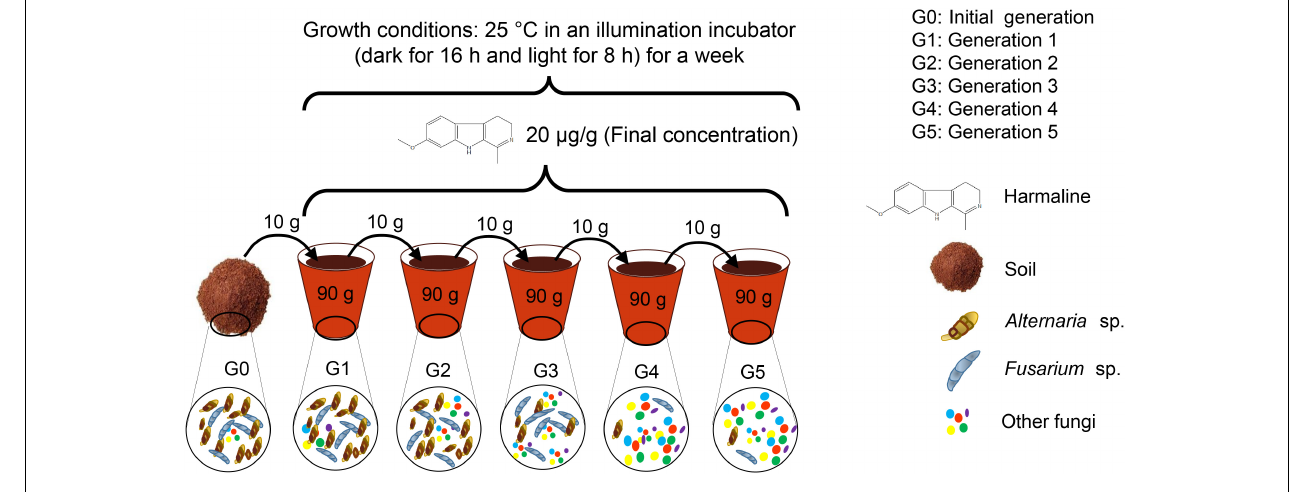
FIGURE 1 | Consecutive cultivation method.